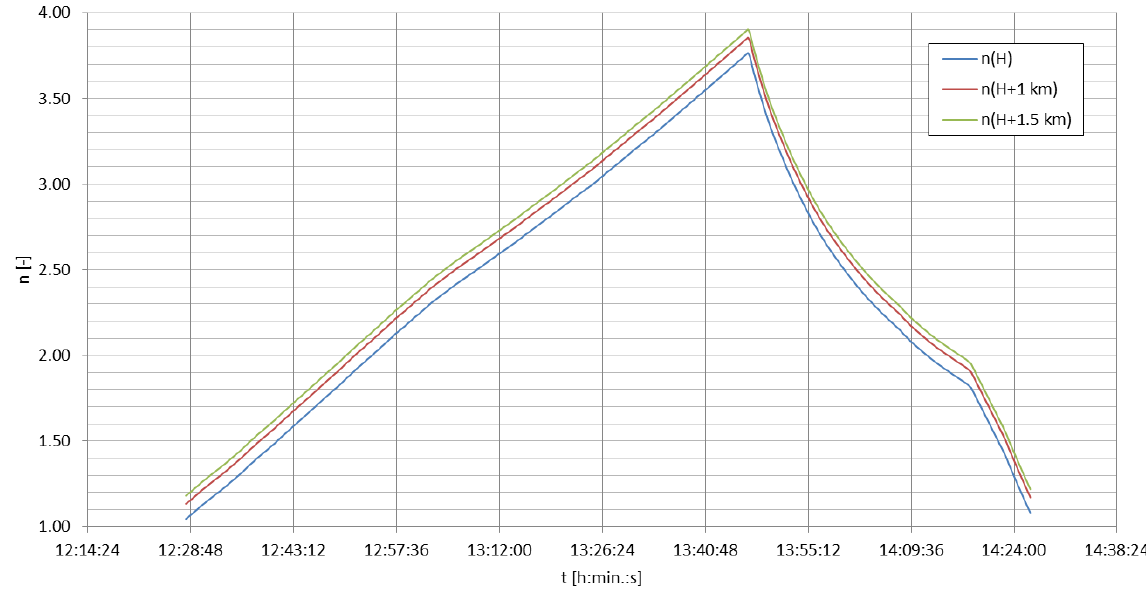
Figure 10. The changing number of lobes of the antenna’s power pattern plotted as a function of the mission’s altitude (time t in UTC). For comparative purposes, two curves for the hypothetical penetration depth (waveguide expansion) of 1 km and 1.5 km have been added. Even for such significant changes (in the order of km instead of m), the number of lobes in the pattern does not change significantly and is always below 4.